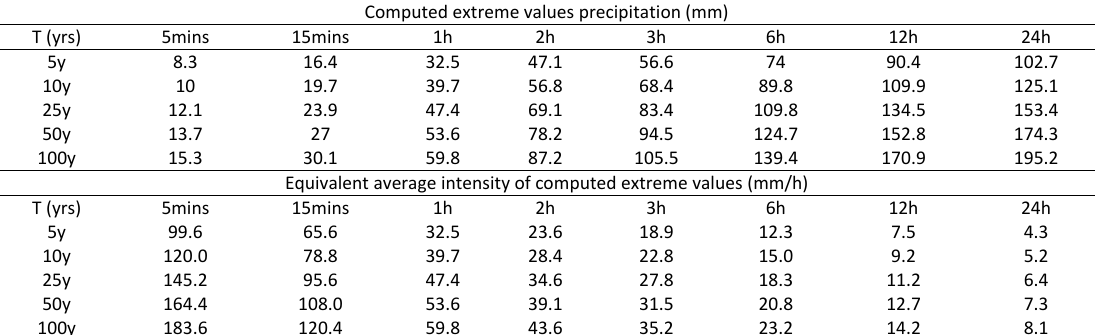
Table 1. 24-hour RIDF data from General Santos rain gage station (PAGASA, 2019)